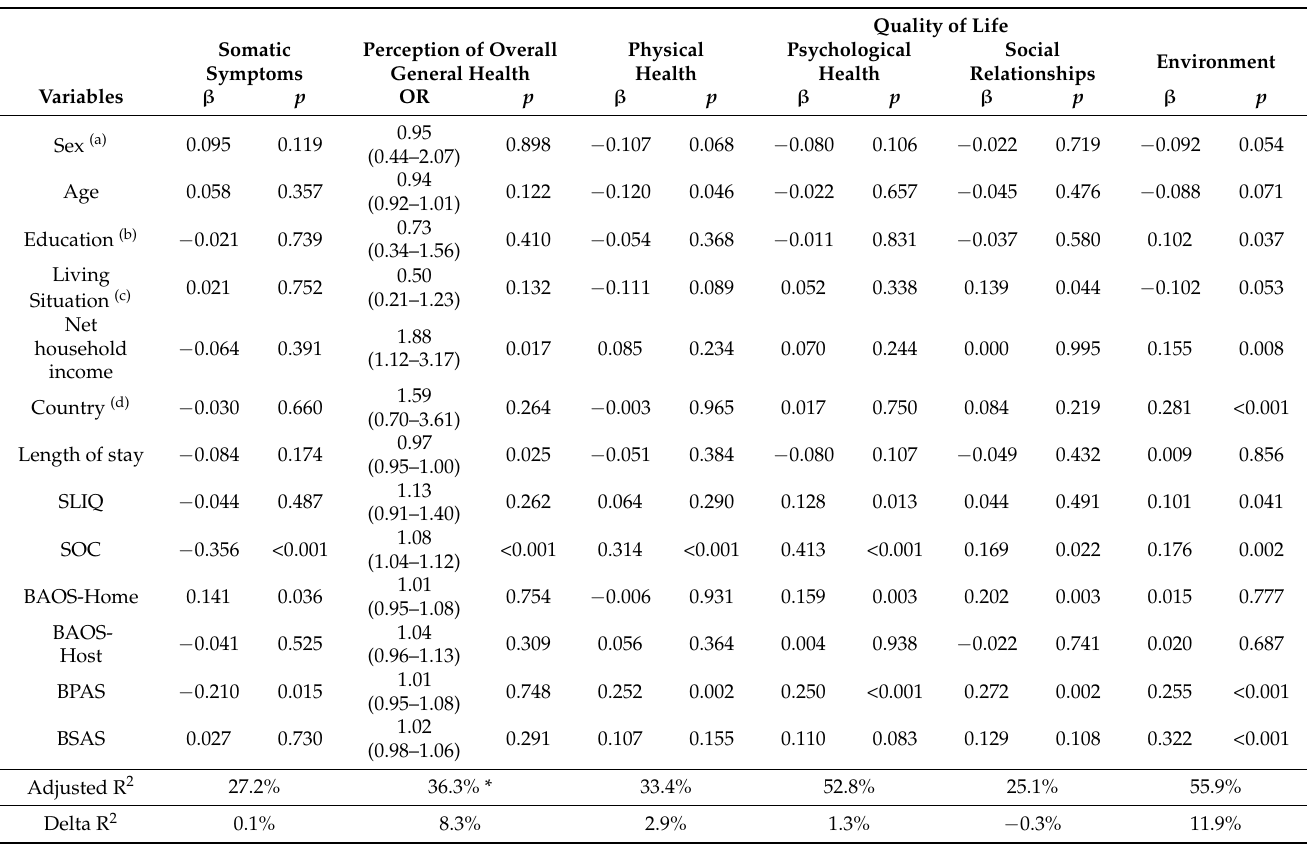
Table 7. Associations between perceived health, quality of life, and predictor variables—adjusted linear regression